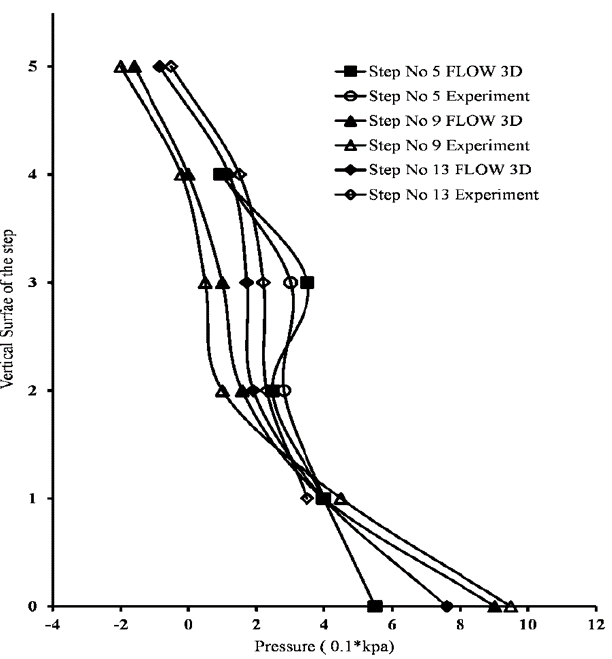
Figure 7. Pressure profiles along the vertical surface of steps.